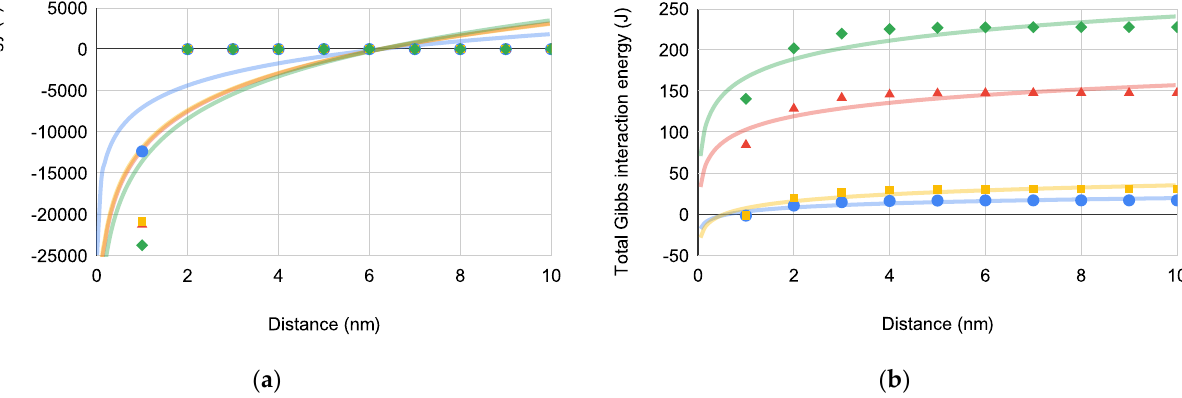
Figure 5. 𝛥𝐺 𝑡𝑜𝑡 (× 10 −9 ) versus distance for bacterial interactions [PA (blue circles), EC (green diamonds), SA (red triangles), and SE (orange squares)] with ( a ) 𝛥𝐺 132𝑡𝑜𝑡 where 𝑑 𝑒𝑞 = 6.56 ± 0.0274 𝑛𝑚 ( N = 4) and ( b ) 𝛥𝐺 13𝑡𝑜𝑡 where 𝑑 𝑒𝑞 approximates that of PBS for both PA and SE.